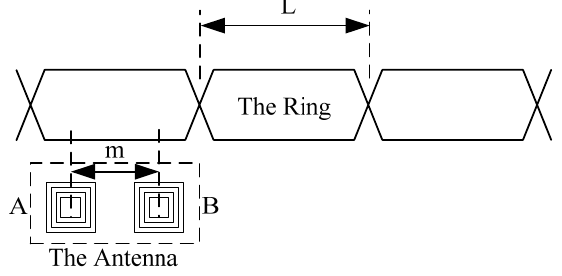
Figure 3. The relative position between the coils and the ring as the two coils produce voltage with the same phase.